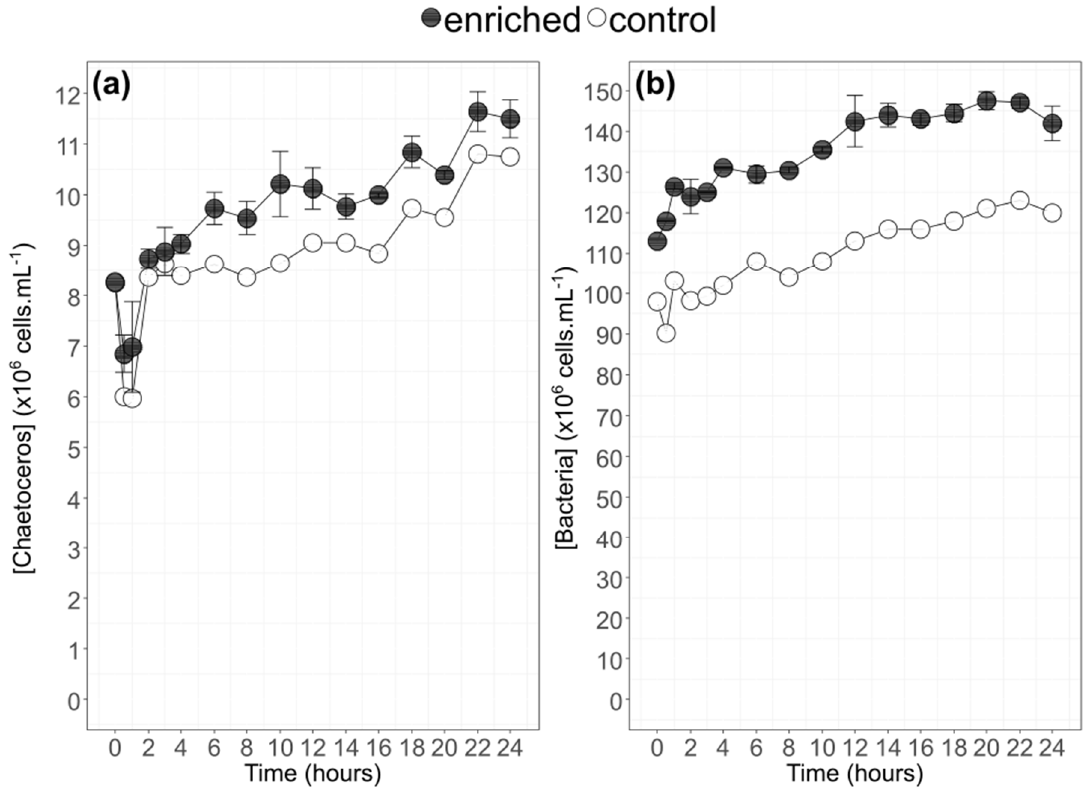
Figure 3. Dynamics of cell concentrations of the two enriched balloons of Chaetoceros muelleri (mean ± SD; solid line ● n = 2) and of the control balloon (solid line ○ ) ( a ) and the corresponding bacteria concentrations ( b ) during the 24 h experiment.